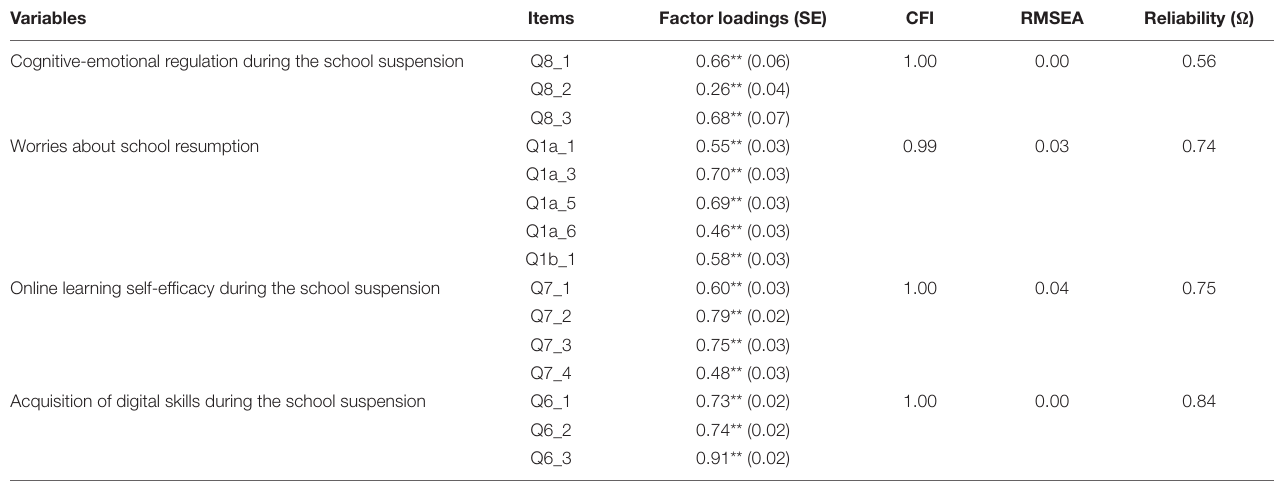
TABLE 3 | CFA for student outcome variables (primary schools).